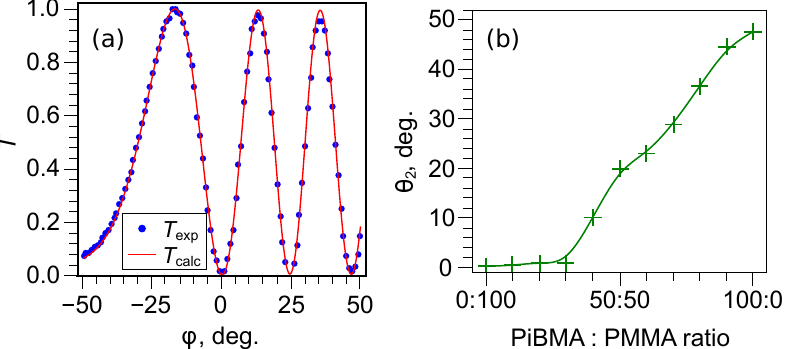
Figure 8. ( a ) Experimental T exp and theoretical T calc dependencies of transmittance from the incidence light angle ϕ obtained for LC cell with the orienting film of PiBMA:PMMA:LN-396 = 70:30:20. The theoretical dependence T calc is obtained for an LC cell with the thickness d = 20.5 µ m, and the director tilt angles θ 1 = 0.3 ◦ and θ 2 = 28.9 ◦ . ( b ) Dependence of the director tilt angle θ 2 at the substrate covered with the PiBMA:PMMA:LN-396 mixture from the polymer ratio.